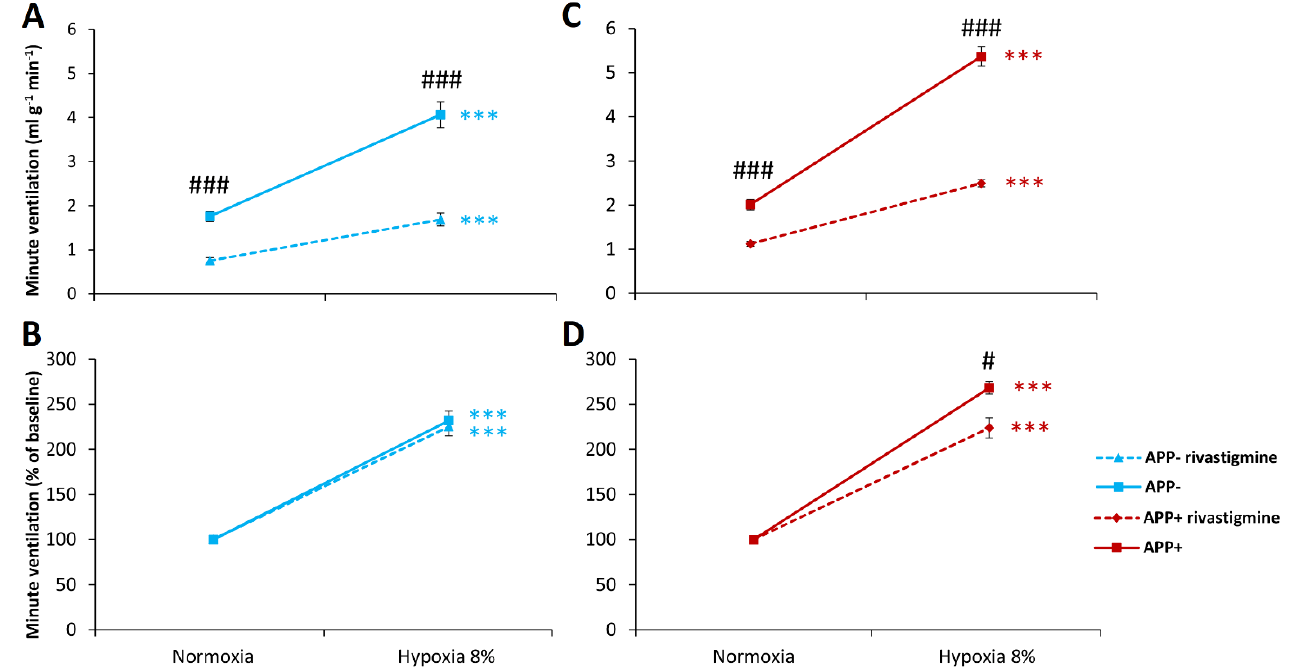
Figure 3. Minute ventilation (V E ) during air breathing (normoxia) and ventilatory response to hy- percapnia in APP+ (red line) and APP− mice (blue line) before (solid line) and after memantine in- jection (dashed line) ( A , B ). Minute ventilation expressed as a percentage of baseline (normoxia) val- ues ( C , D ). Note the lack of difference in hypercapnia reactivity in the two groups of mice. The data are presented as mean ± SEM, ** p < 0.01, *** p < 0.001 vs. normoxia value, # p < 0.05. ## p < 0.01 vs.